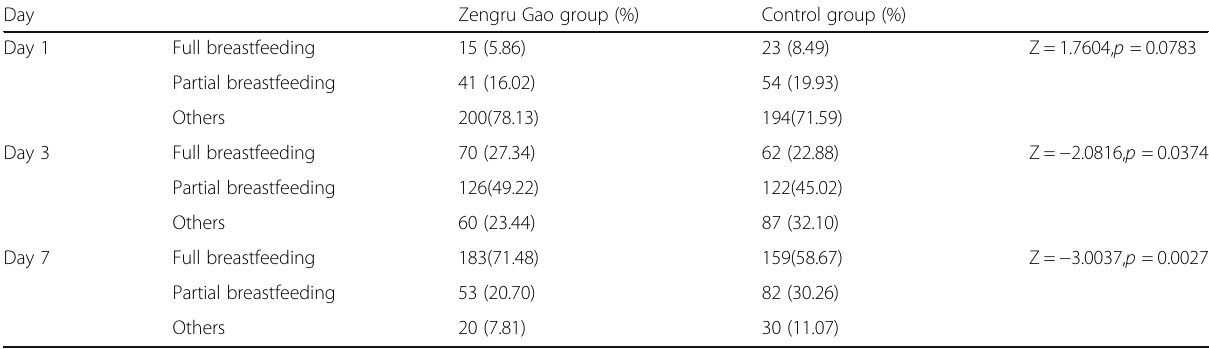
Table 2 Comparison of full and partial breastfeeding at day 1, day 3, and day 7 between groups randomized to Chinese herbal medicine Zengru Gao and no intervention